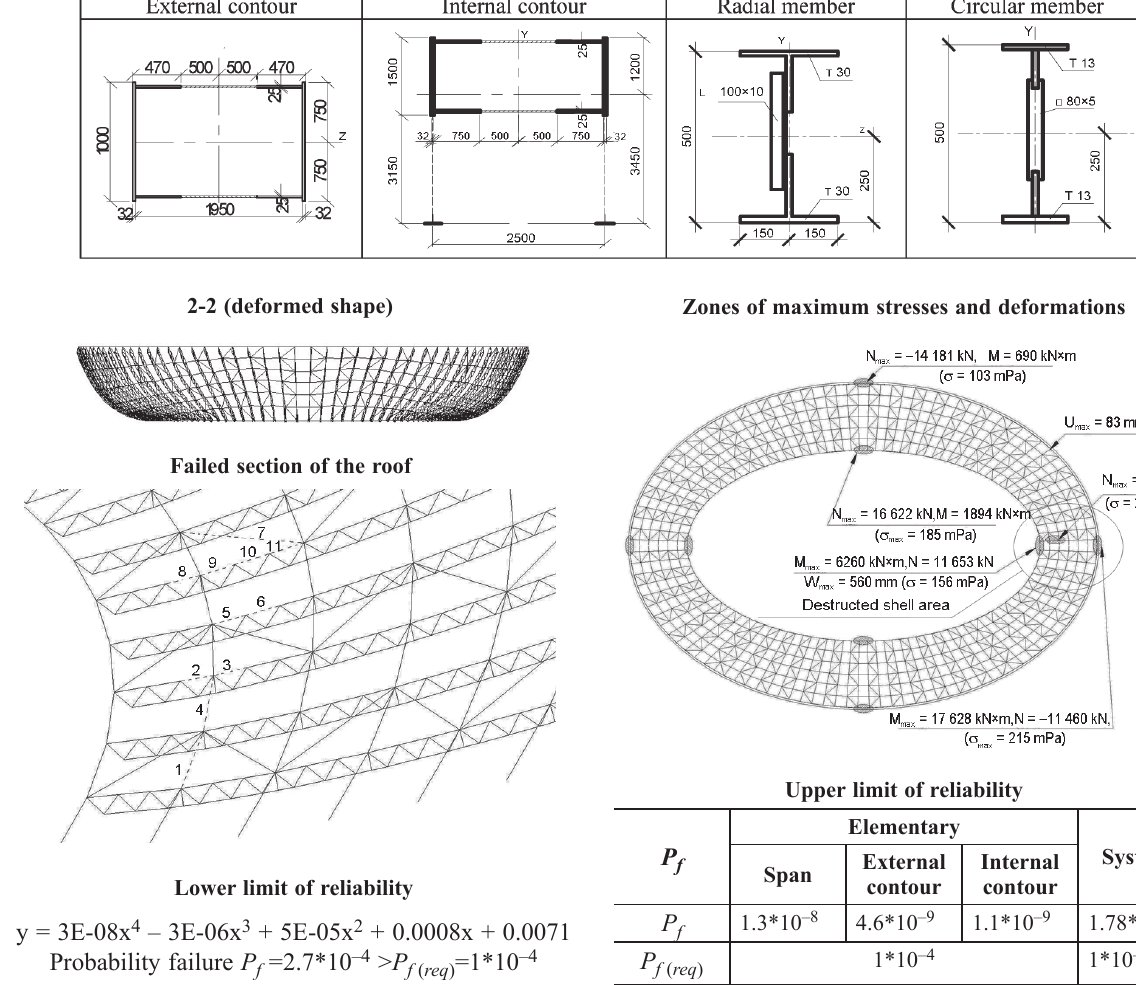
Fig. 6. Example of the design of lattice shell with an elliptical opening formed using the system of rigid threads of the through